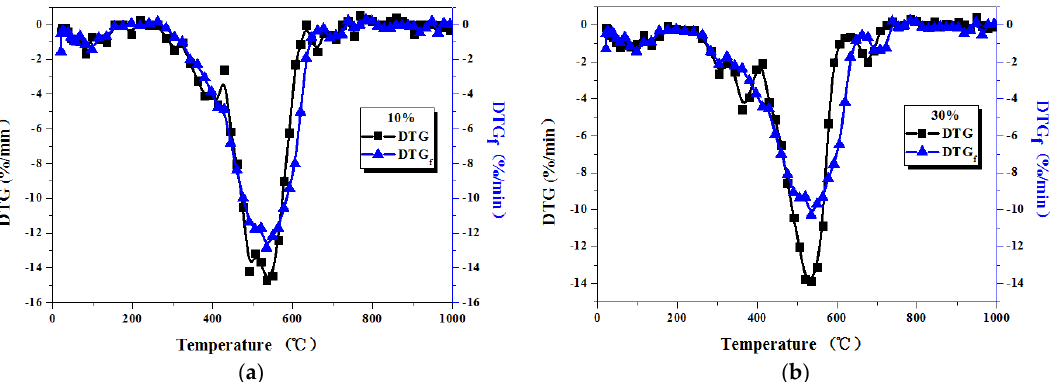
Figure 4. Actual and fitted DTG curves for coal-sludge (S 2 ) blends of different dried sludge weight percentages (heating rate = 30 °C/min) (( a ) 10%; ( b ) 30%).